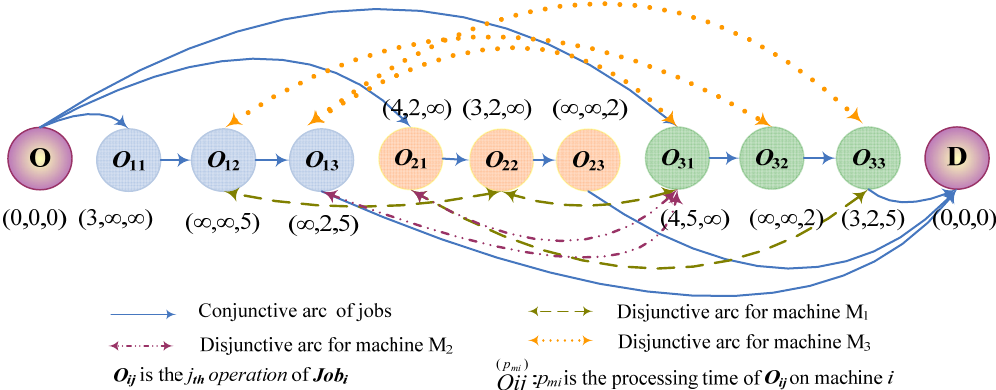
Figure 1. An example of the flexible job scheduling problem